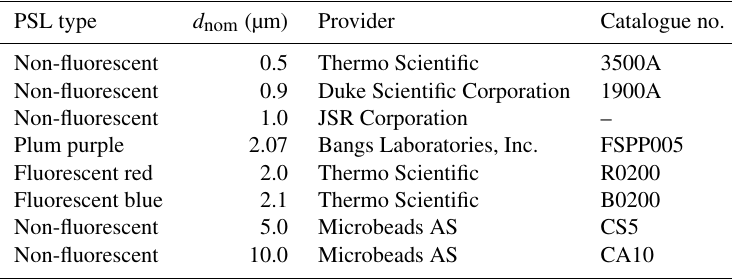
According to the PSL manufacturers, the refractive index of the non-fluorescent and the red and blue fluorescent particles was 1.59 (589 nm , 25 ◦ C ). No information was available regarding the refractive index of the plum purple PSL particles. Table 2. Average particle concentrations measured by the three devices tested ( C DUT ), the reference optical particle counter ( C ref ), and